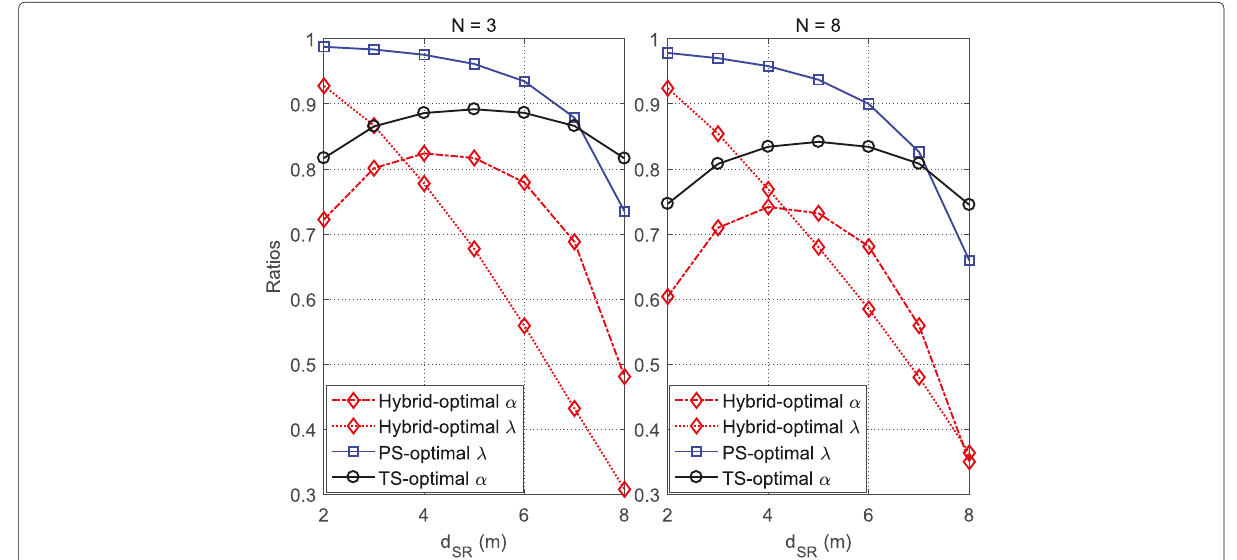
Fig. 11 Optimal α and λ under different protocols versus d SR , SNR =